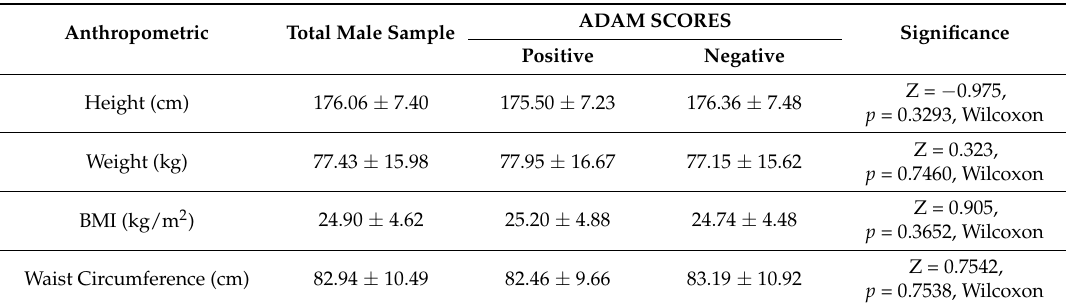
Table 2. Anthropometrics by ADAM scores. Height, weight, and BMI of the overall sample, including comparison between positive and negative ADAM scores with no statistically significant difference